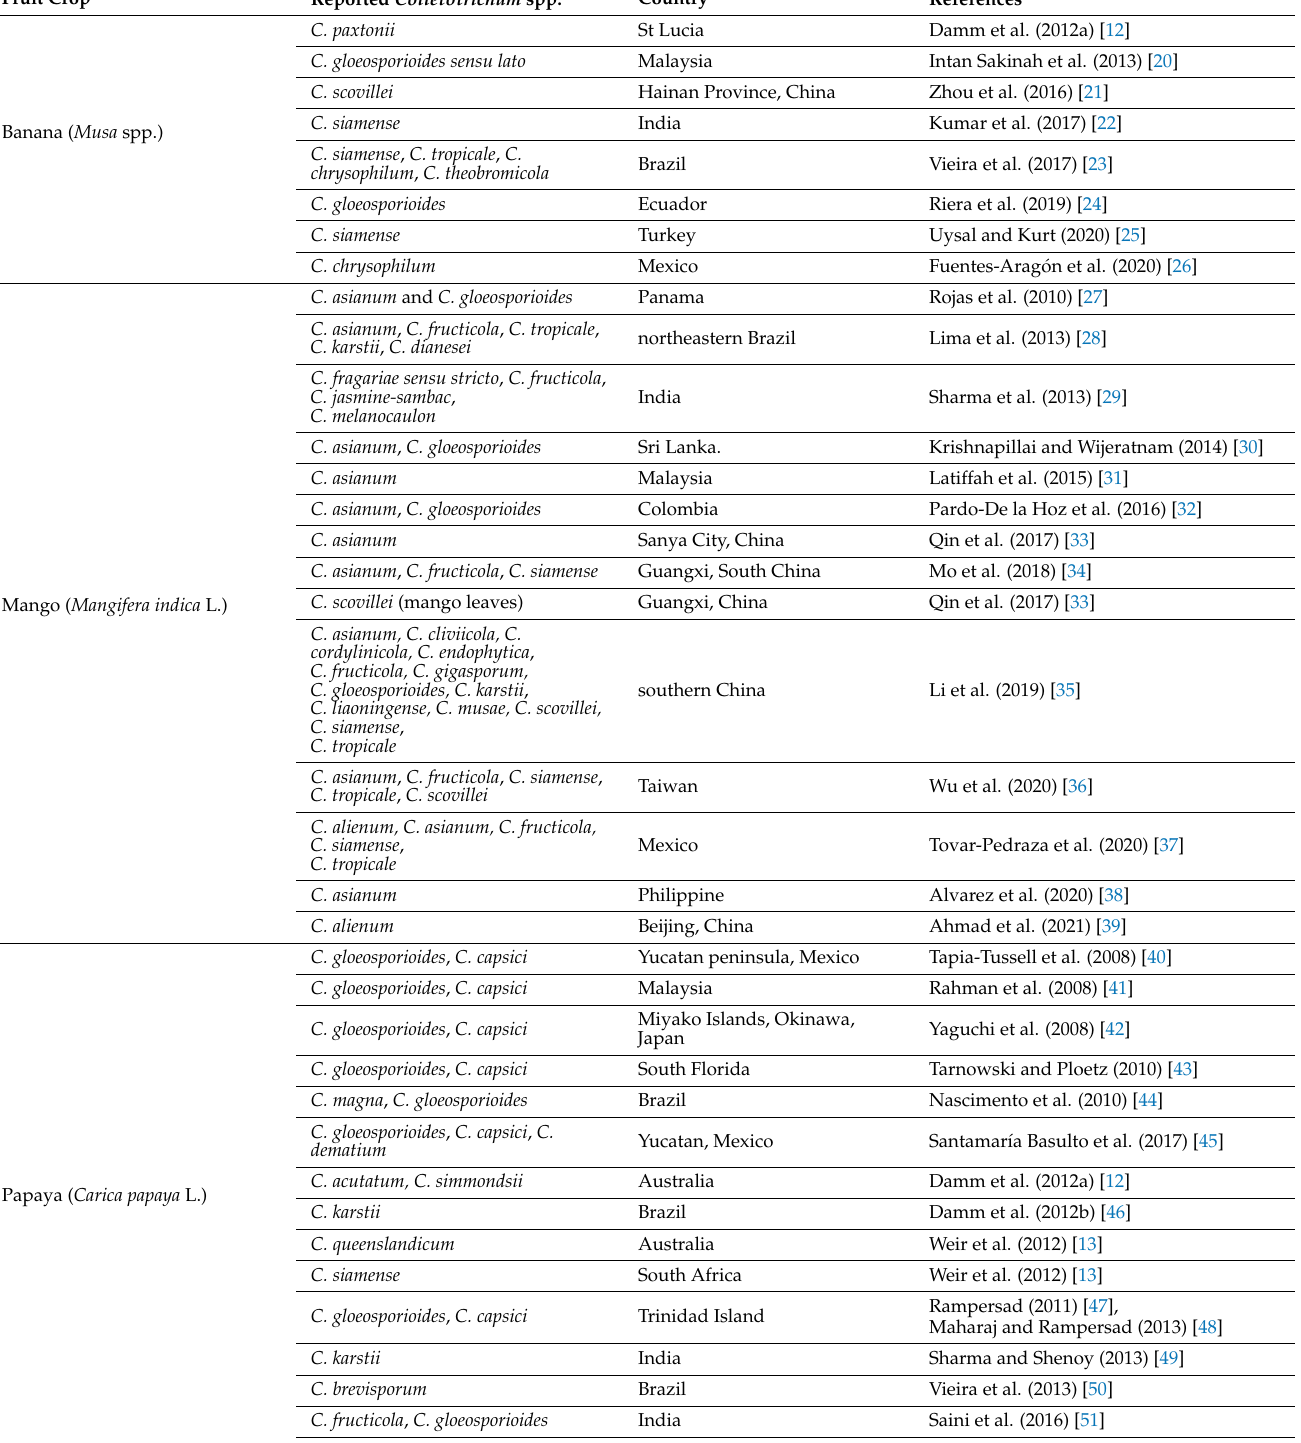
Table 1. Species of Colletotrichum associated with tropical fruit crops reported in several countries. Fruit Crop Reported Colletotrichum